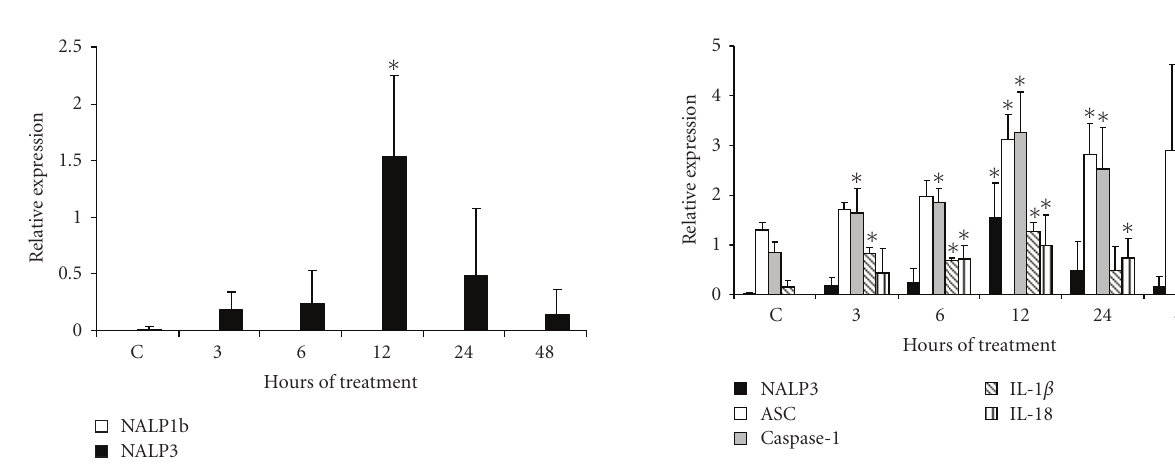
Figure 2: Semiquantitative analysis of NALP3 and NALP 1b mRNA expression in the eye of LPS-treated mice . Mice were treated with LPS during 3, 6, 12, 24, and 48 hours. NALP3 and NALP1b mRNA expressions were determined by RT-PCR. Average of 5 mice analyzed in each assayed time is reported. Asterisk indicates significant di ff erence compared with the control ( P < . 05) analyzed by Kruskal-Wallis and Turkey tests.